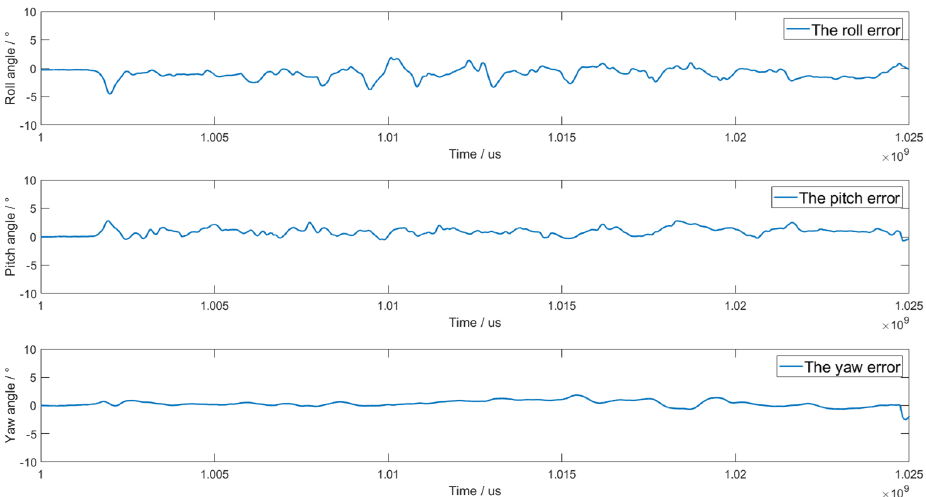
Figure 18. Attitude tracking errors with a half-full water